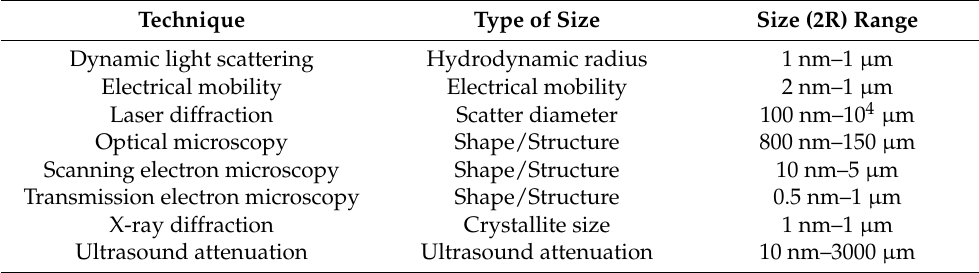
Table 1. The common sizing techniques and their characteristics.